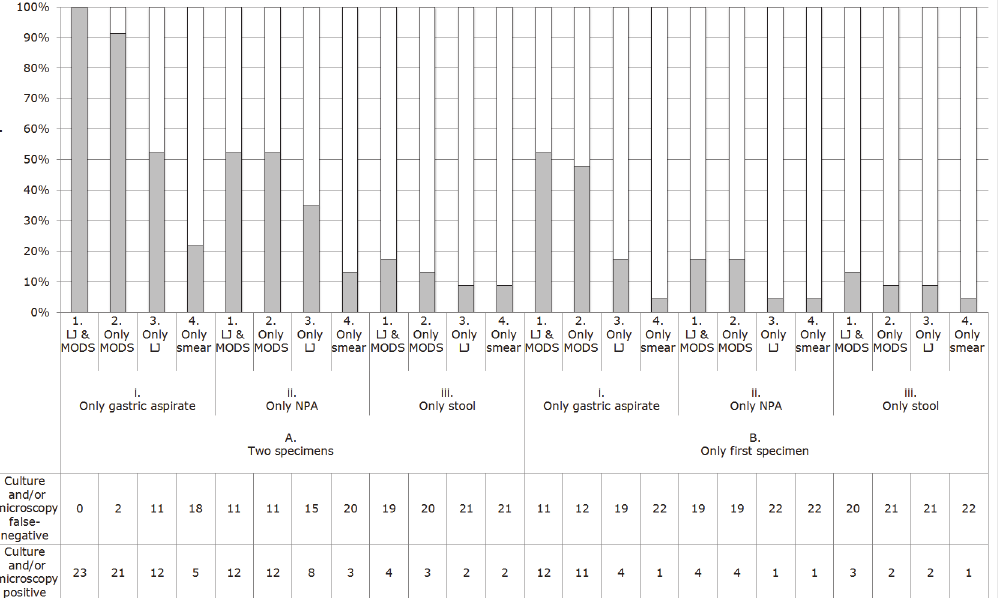
Fig 3. Tuberculosis (TB) microscopy and culture test results for specimens from the 23 cases with culture-positive TB. All subjects had two specimens of each type analyzed for TB by the methods shown. The graph shows the proportion (and the data table the number) of patients who had positive results in (A.) at least one of their two specimens and (B.) who had positive results in the first specimen of their two specimens, with separate bars indicating results for stool, nasopharyngeal aspirate (NPA) or gastric aspirate specimens tested only by auramine microscopy (smear), Lowenstein-Jensen (LJ) solid culture, or microscopic-observation drug-susceptibility (MODS) liquid culture [e.g. the first bar demonstrates that all 23 cases would have been diagnosed if only (1.) LJ and MODS culture had been performed (i.e. without microscopy) on (A.) duplicate gastric aspirate